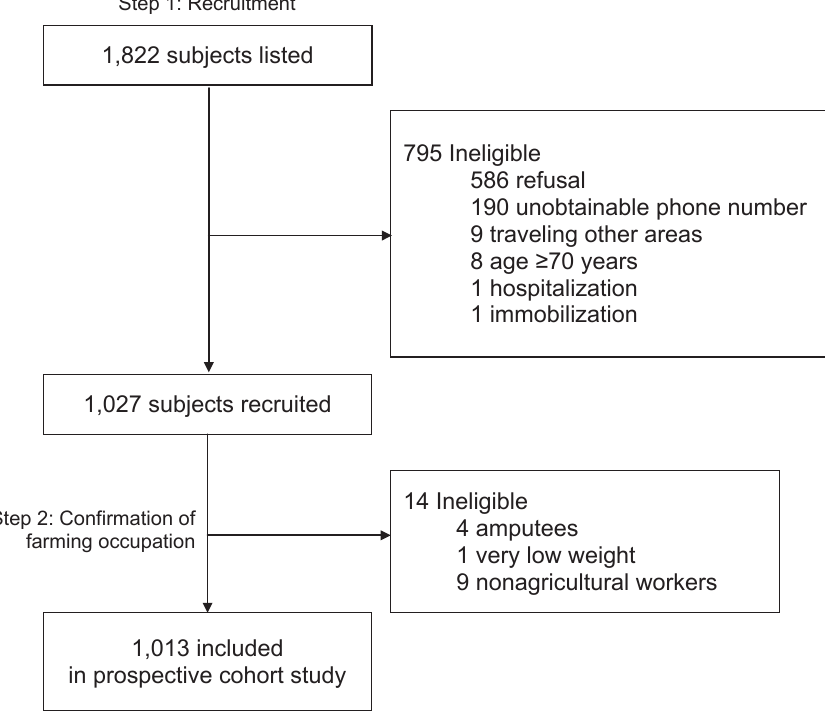
Figure. Inclusion fl